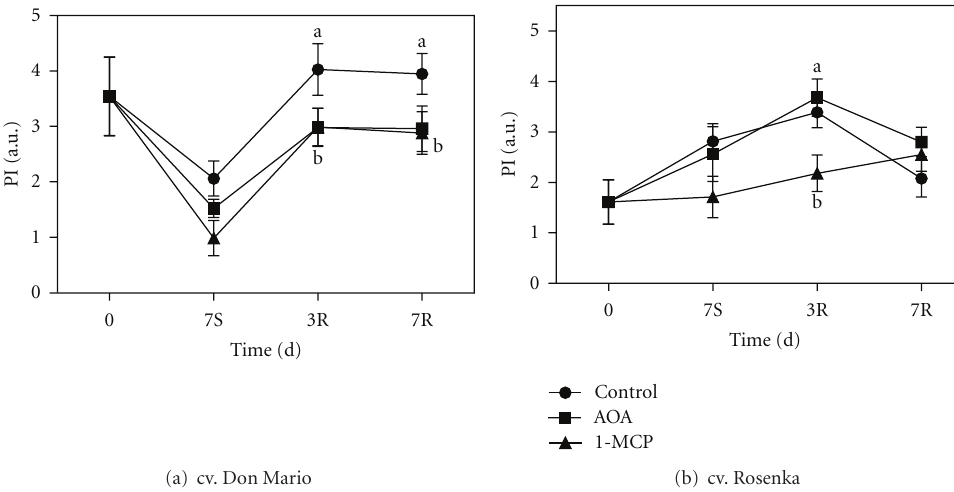
Figure 9: Performance index (PI) measured from leaves of cv. Don Mario (a) and cv. Rosenka (b) stored for 7 days (7S) at 14 ◦ C and transferred at 20 ◦ C for recovery evaluation (3R and 7R). Values are means with standard errors ( n = 10). Data were subjected to one-way ANOVA, and di ff erent letters, when present, mean that values are statistically di ff erent, P < 0 . 05. The performance index (PI) in the cv. Don